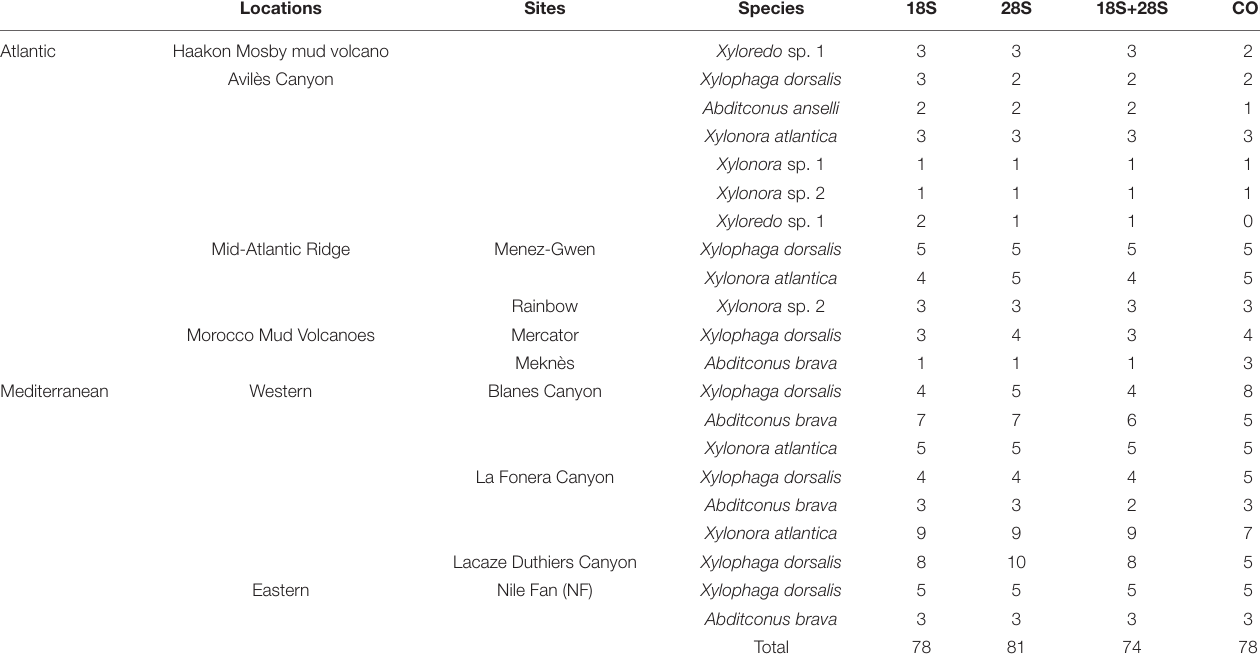
TABLE 2 | Number of specimens per species used for each genetic analysis.